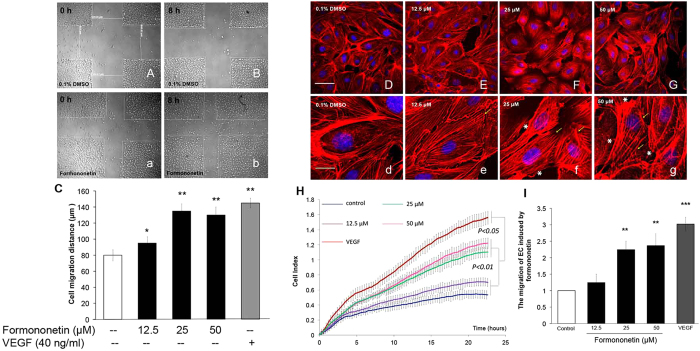
Formononetin induced cell migration and stress fiber formation in HUVECs.Formononetin enhanced the migration of HUVECs following scrape injury. (A,B) Serum-starved HUVEC monolayers were wounded (0 h) by micro-tips and washed with PBS, followed by addition of (A,a) 0.1% DMSO medium or (B,b) 25 μM formononetin for 8 h. (C) Statistical analysis of cell migration recorded by phase contrast microscopy following each scratch. The extent of migration was determined by averaging the mean length of the scraped area (gap width) of the migration pattern of endothelial cells. Formononetin also induced the rearrangement of actin cytoskeleton in HUVECs. Serum-starved HUVECs were treated with (D,d) 0.1% DMSO as control, and formononetin at (E,e) 12.5, (F,f) 25 and (G,g) 50 μM for 8 h. Cell nuclei were labeled with Hochest 33342 and F-actin was labeled with tetramethyl rhodamine isothiocyanate (TRITC)-phalloidin. Formononetin increased the formation of stress fibers that terminated at pointed edges (yellow arrowhead) and growth lamellipodia (white asterisk). White and yellow scale bars represent 50 and 20 μm, respectively. (H) HUVECs migration in response to different concentrations of formononetin was analyzed using the xCELLigence system. Real-time cell migrations of serum-starved HUVECs following the treatment of 12.5, 25 and 50 μM formononetin for 24 h were recorded. (I) Statistical analysis of the migration index of the xCELLigence system following formononetin treatments for 20 h. 40 ng/ml of VEGF was served as a positive control. Values are given as the increment of migration ± SD (n = 3), for three independent experiments. **p < 0.01, **p < 0.001 vs. control.